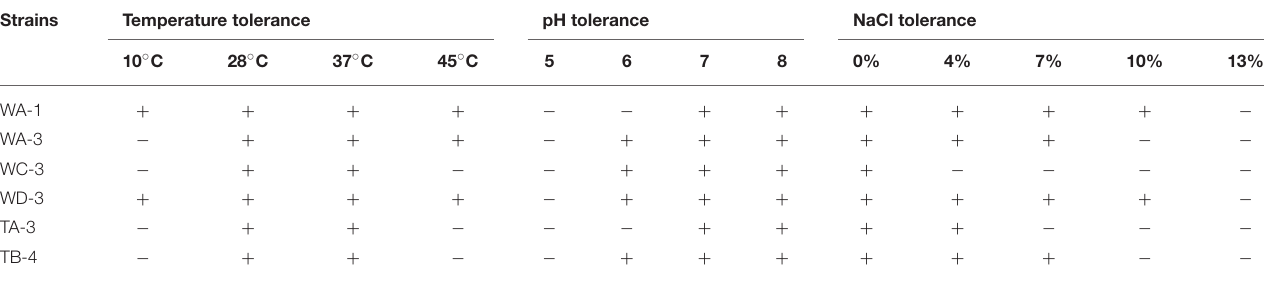
TABLE 2 | Temperature ( ◦ C), pH and NaCl (%) tolerance of the selected rhizospheric actinomycete